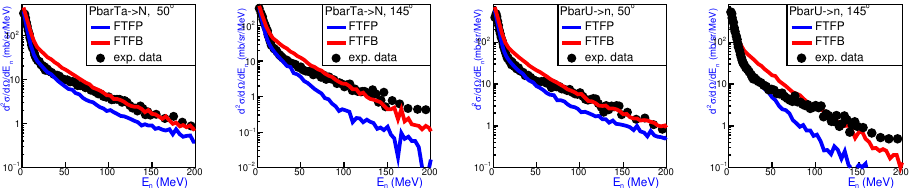
Figure 4. Inclusive cross sections of neutrons produced in antiproton interactions with Ta and U at projectile momentum 1.22 GeV / c. Points are experimental data [5]. Blue and red lines are calculations by the FTFP and FTFB models, correspondingly